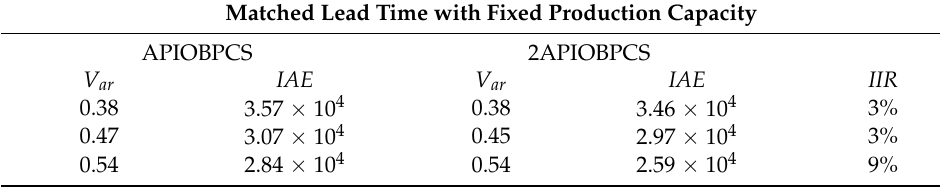
Table 3. Performances of Case 2 for the two